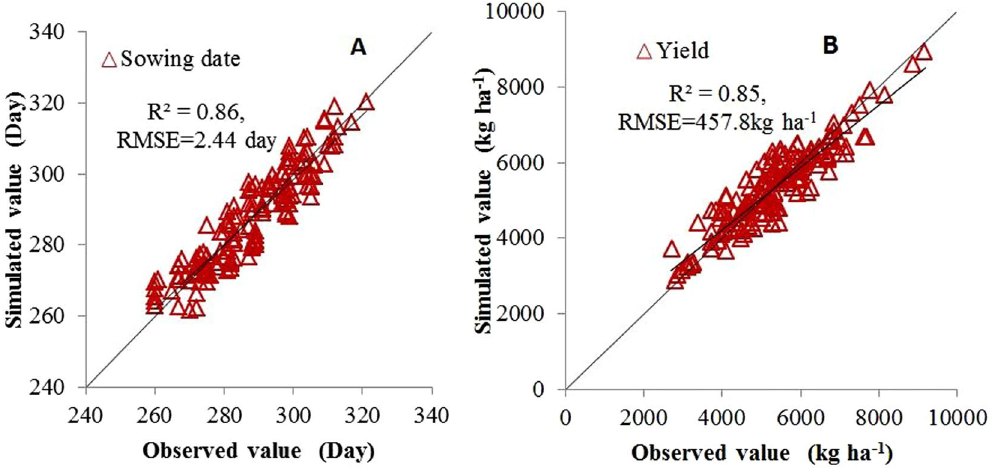
Figure 2. Validation of the interpolation method for wheat sowing dates and actual yield from 1998 to